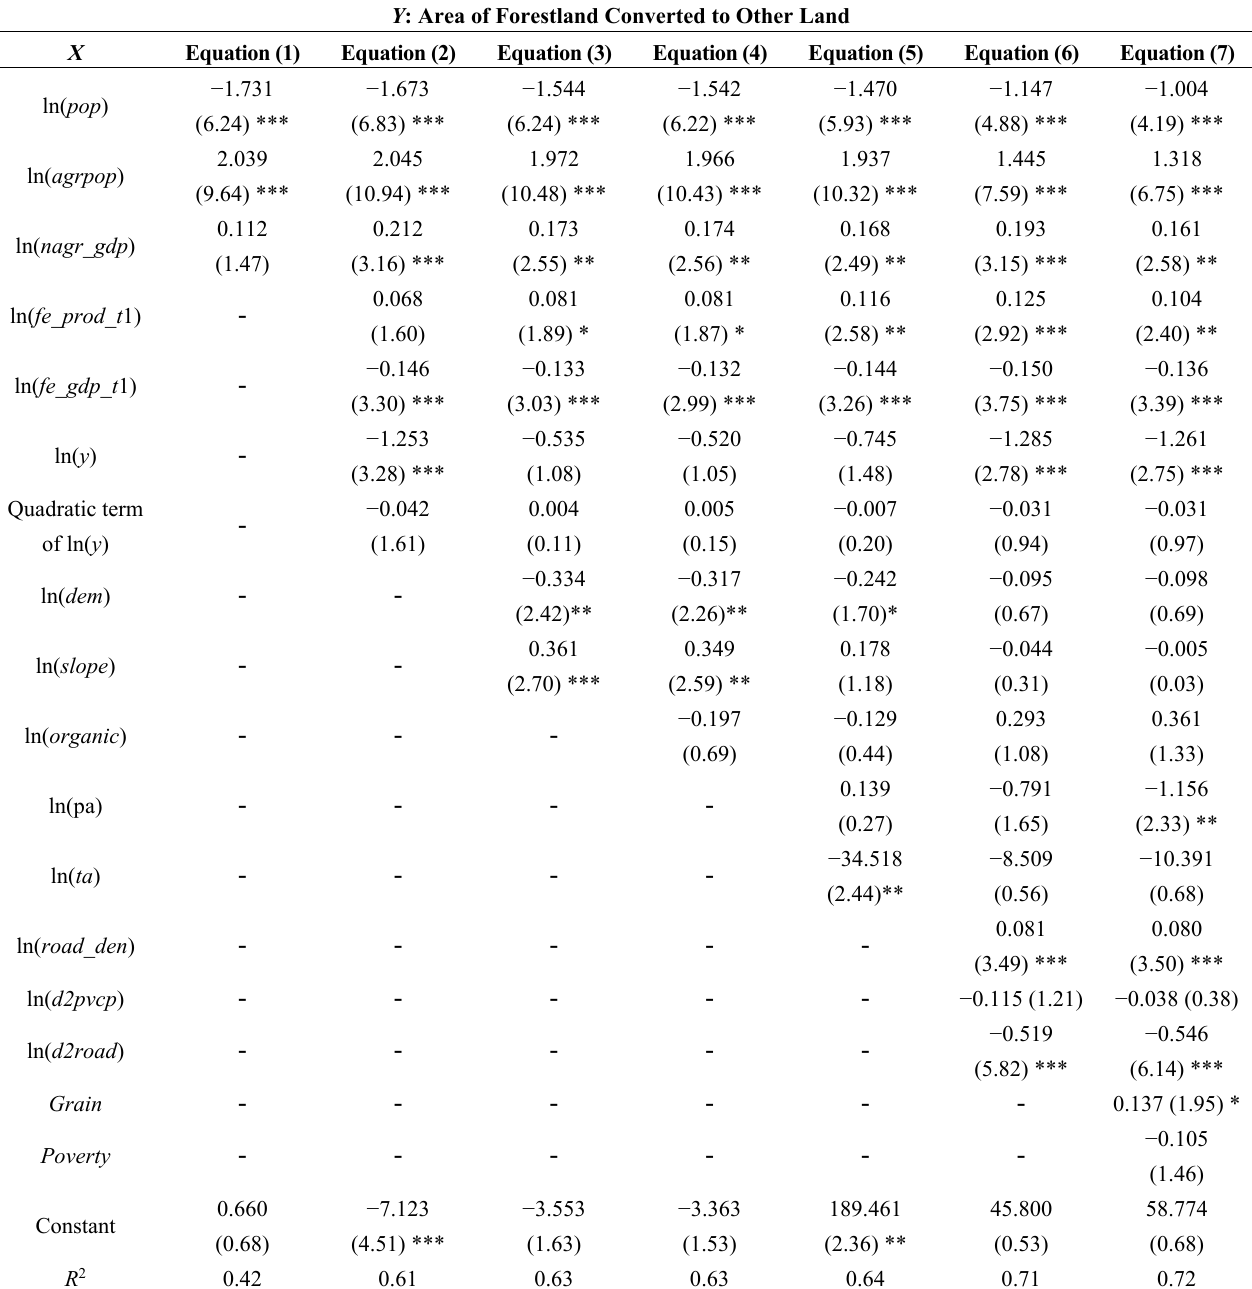
Table 4. Driving mechanism analysis of the deforestation